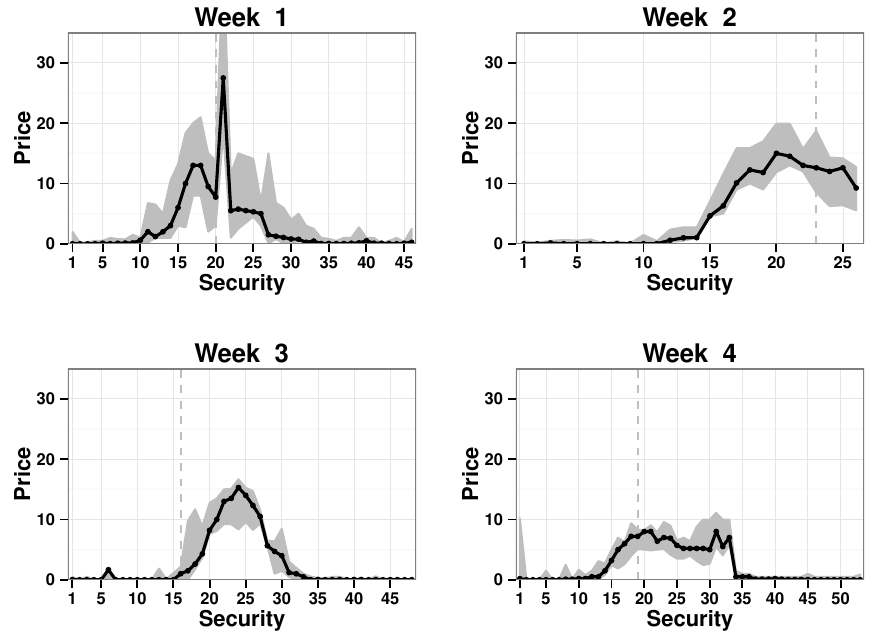
Figure A.1: Experiment 1: For a given week and a given epoch of four hours, we took the median price of all transactions within that epoch. Then we constructed the average price over the 31 median prices of the 31 epochs of each week with 95% confidence intervals. The four panels show the resulting distribution of prices over all securities in each week. The security whose state was realised at the end of the week (payout of 100 units) is marked with the dashed